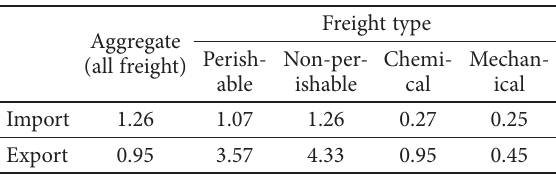
Table 6. Elasticity of commodity with respect to